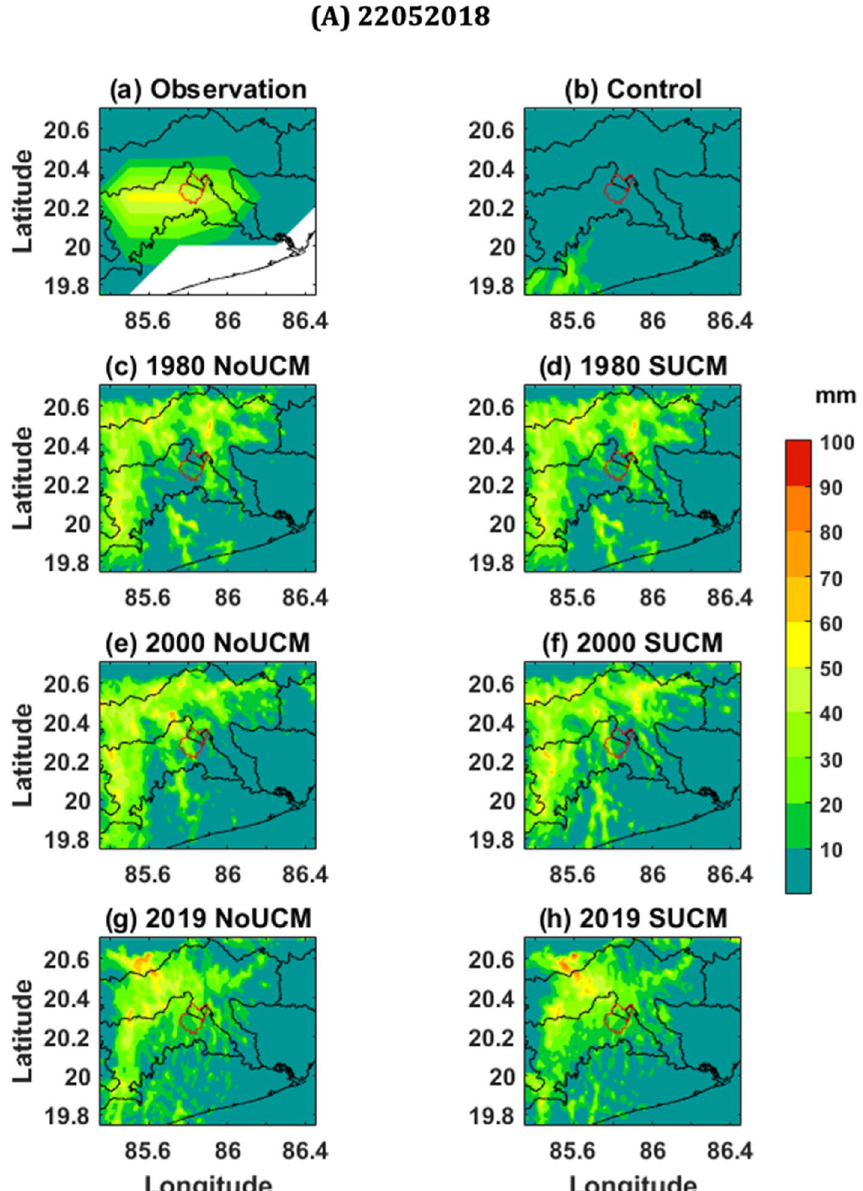
Fig. 2 Spatial representation of rainfall from for 22052018 case from a GPM observation, b Control run, c 1980 NoUCM, d 1980 SUCM, e 2019 NoUCM, f 2019 SUCM; red color shape file represents Bhubaneswar